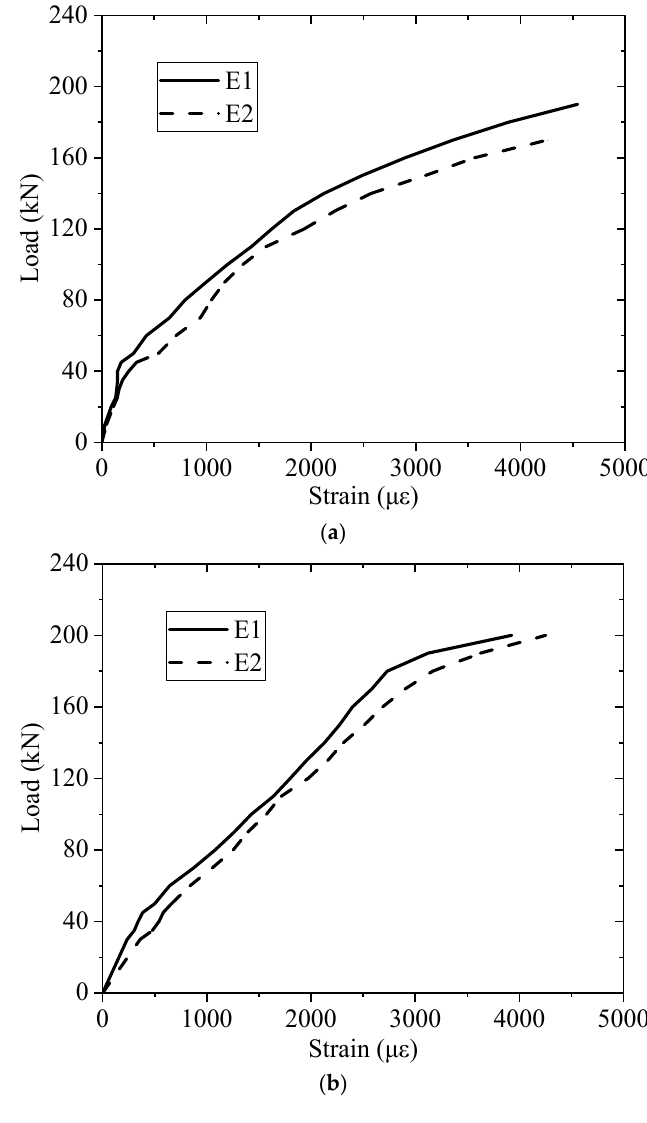
Figure 8. Load-strain relationship of ECC layer at the midspan of beams: ( a )BE1, ( b )BE2.